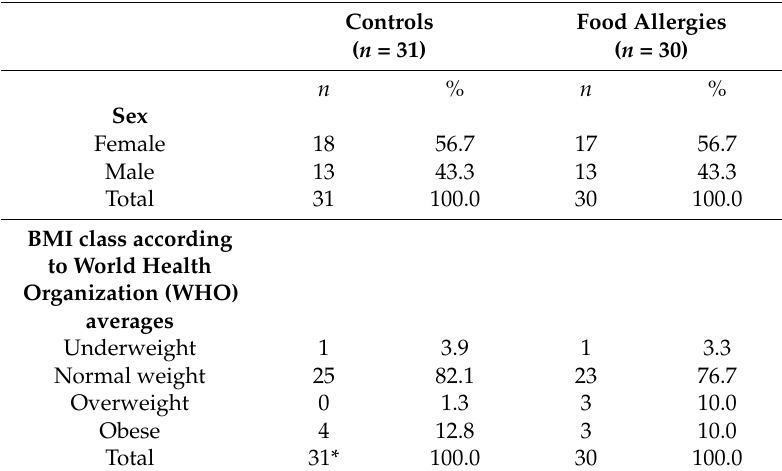
Table 1. Distribution of sex and body mass index (BMI) of the children.